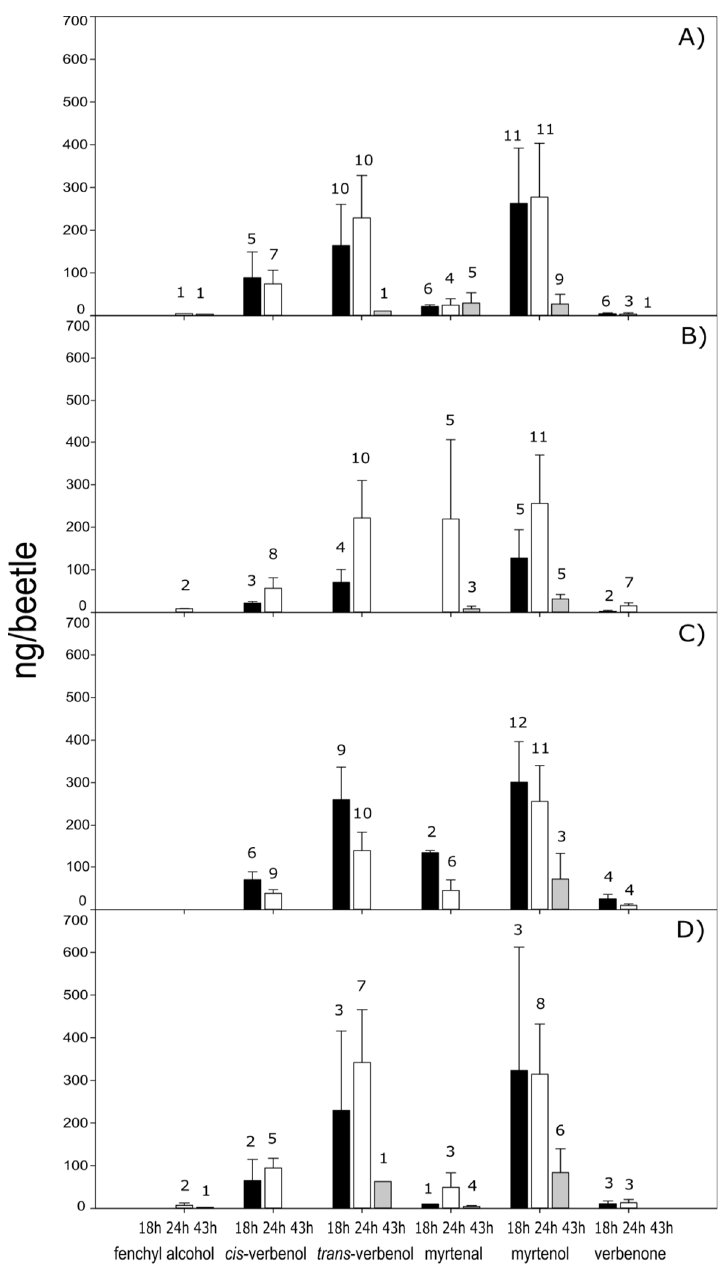
Figure 3. Quantities (mean + SEM) of oxygenated monoterpenes detected in pre-emerged D . rhizophagus adults fed during 18, 24, and 43 h on the phloem of Pinus leiophylla . ( A ) solitary females, ( B ) females paired with males, ( C ) solitary males, ( D ) males paired with females. Numbers above each bar correspond to the number of insects in which the compound was detected out of a maximum of 12 adults tested.